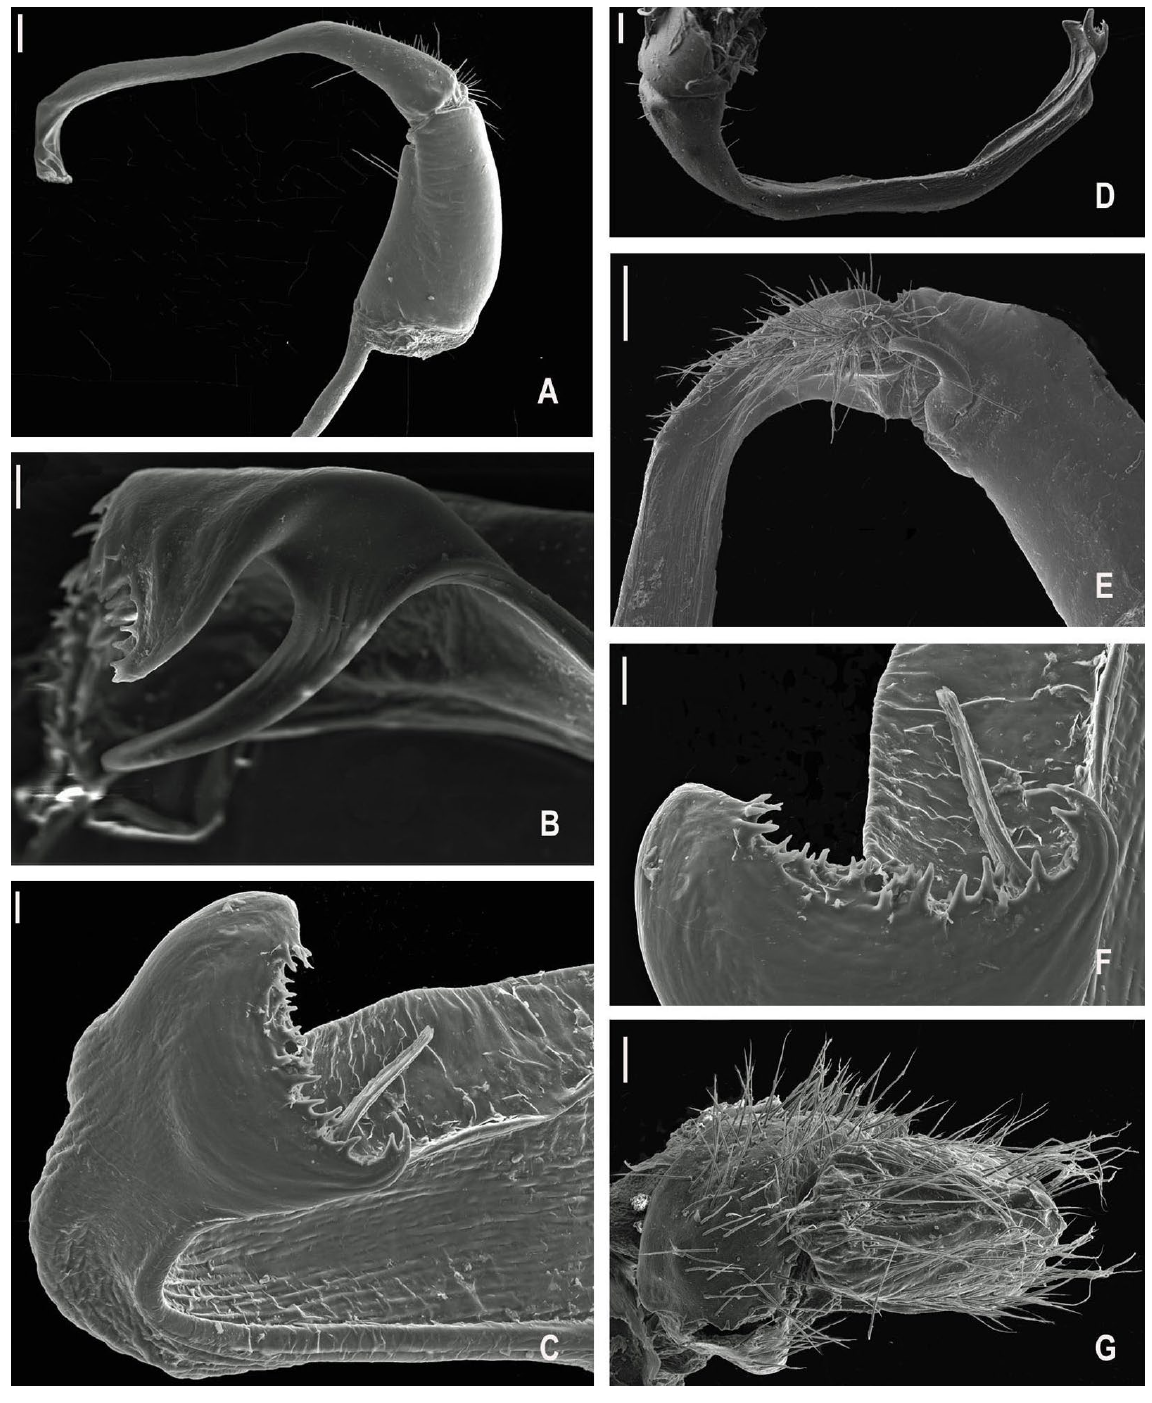
Fig. 2. Levizonus circularis Takakuwa, 1942, ♂♂, ♀, from China (FSCB 12019Ch) (A–B) and Russia (FSCB 232008, 212008) (C–G). A . Gonopod, lateral view, longitudinal striae are not visible. B . Gonopod apex, lateral view. C, F . Gonopod apex, ventral view. D . Gonopod, lateral view, coxite partially destroyed. E . Middle part of gonopod, mesal view. G . Vulva, mesal view. Scale bars: A, E = 200 μm; D, G = 100 μm; B–C, F = 20